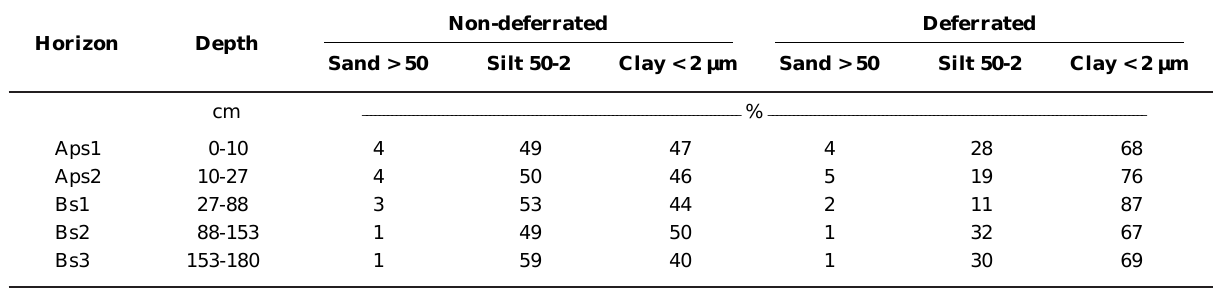
Table 5. Particle-size analysis of profile JM 3 with and without deferration